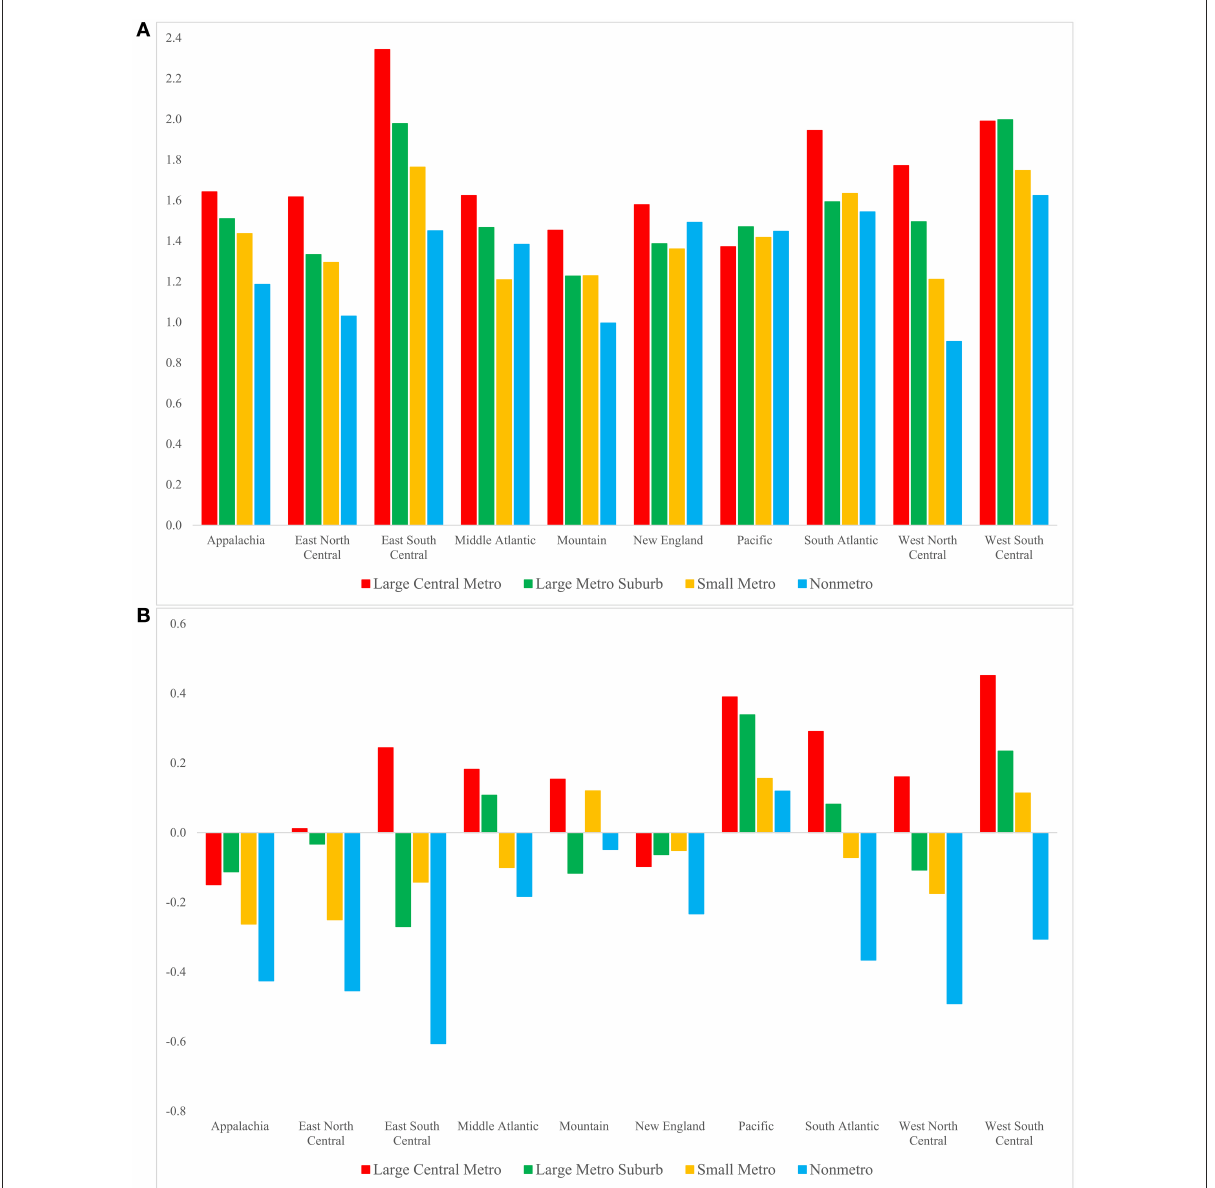
FIGURE2 Contribution of the change in smoking-attributable mortality to the change in life expectancy at age 50 for men (A) and women (B) by region and metropolitan category, 1990–92 to 2017–19. Positive/negative values indicate that changes in smoking-attributable mortality contributed to an increase/decrease in life expectancy. These values are YLLs as defined in Table 1. Standard errors are given in Supplementary Tables S5,